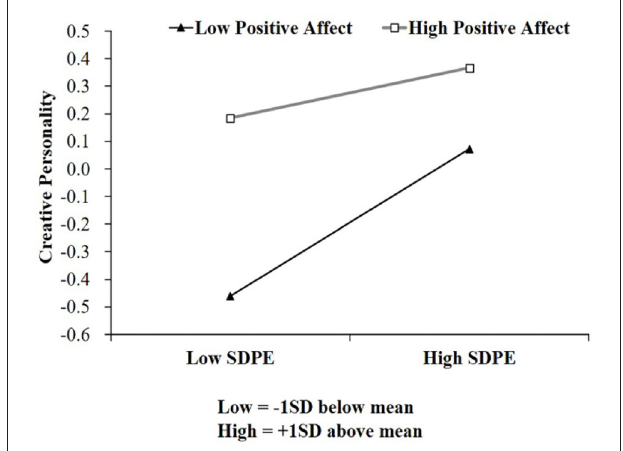
FIGURE 2 | The relationship between self-determination in physical exercise and creative personality for high and low levels of positive affect. N = 1,201, SDPE, Self-determination in physical